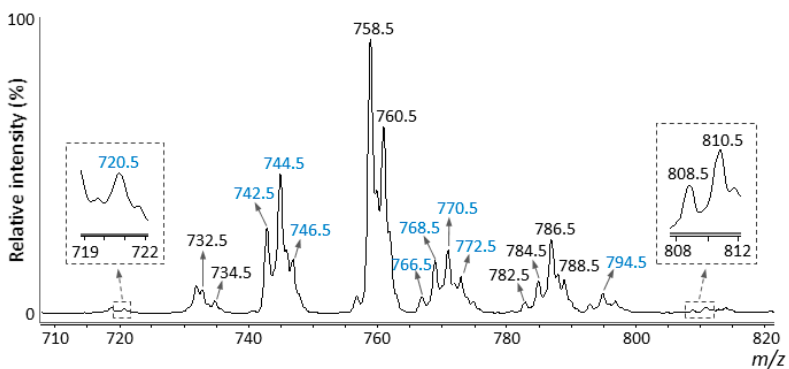
Figure 3. Mass spectrum obtained from the total lipid extract of pork chop sections using LC-MS/MS. Precursor ion scanning at m/z 184.1 in positive ion mode was performed. Peaks with black m/z values indicate diacyl-phosphatidylcholine (PC) species, while those with blue m/z values indicate alkylacyl- and/or alkenylacyl-PC species. All species were detected as [M + H] + ions. Table 1. Phosphatidylcholine (PC) species in pork chop detected by LC–electrospray ionization (ESI)– MS/MS. [M + H] + , m/z